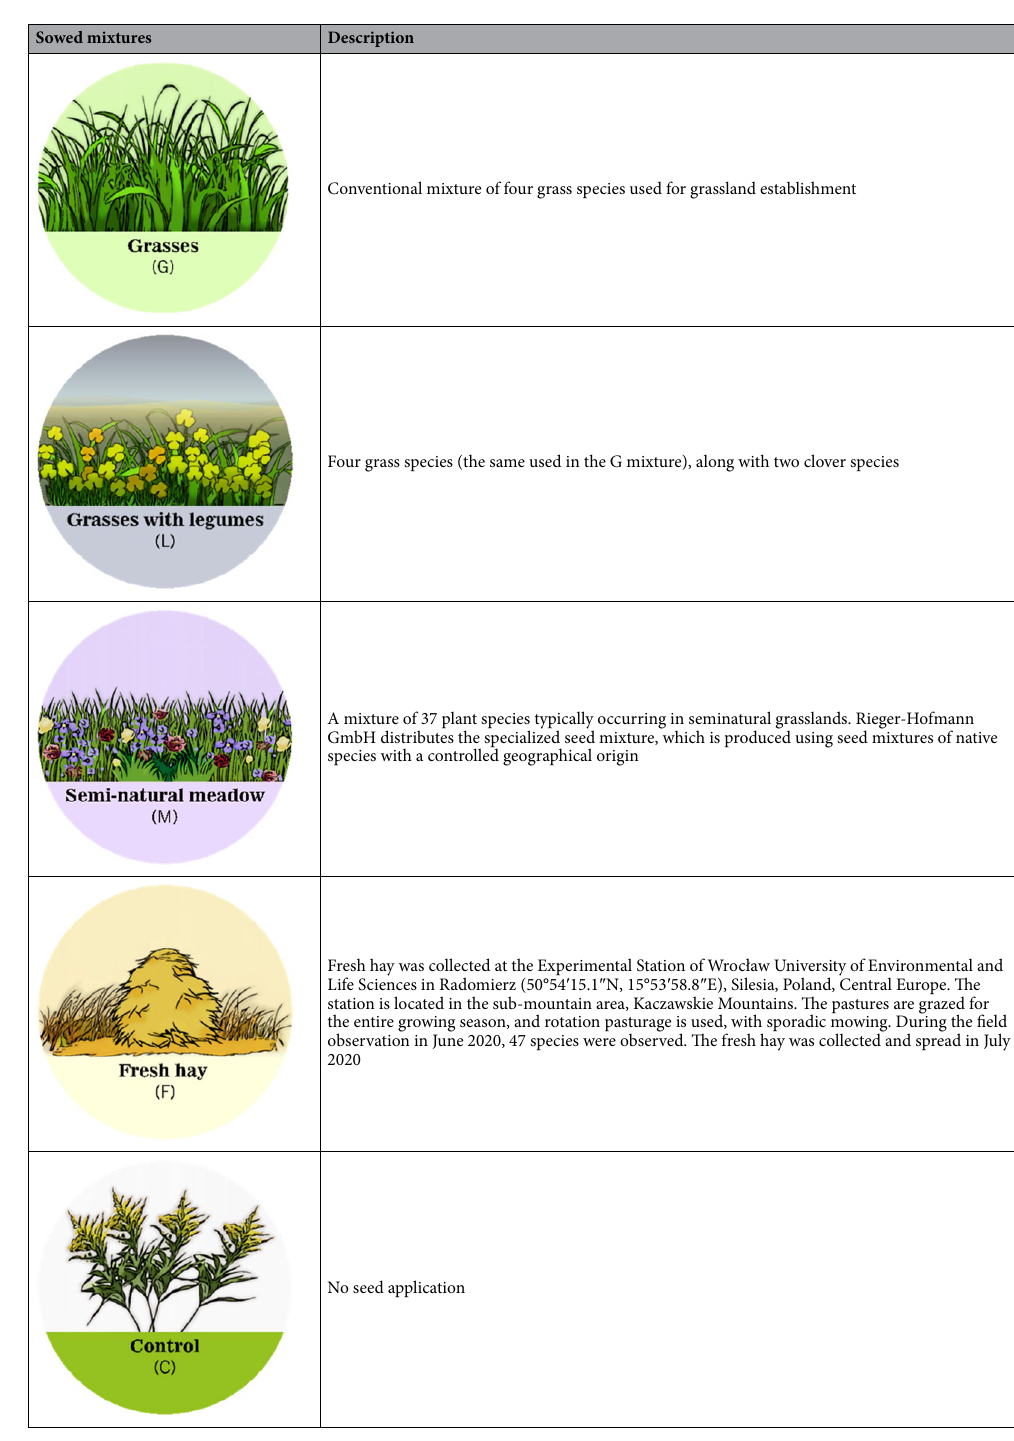
Table 1. Various methods of seed introduction and composition (The species composition of seed mixtures and fresh hay are presented in Supplementary Table